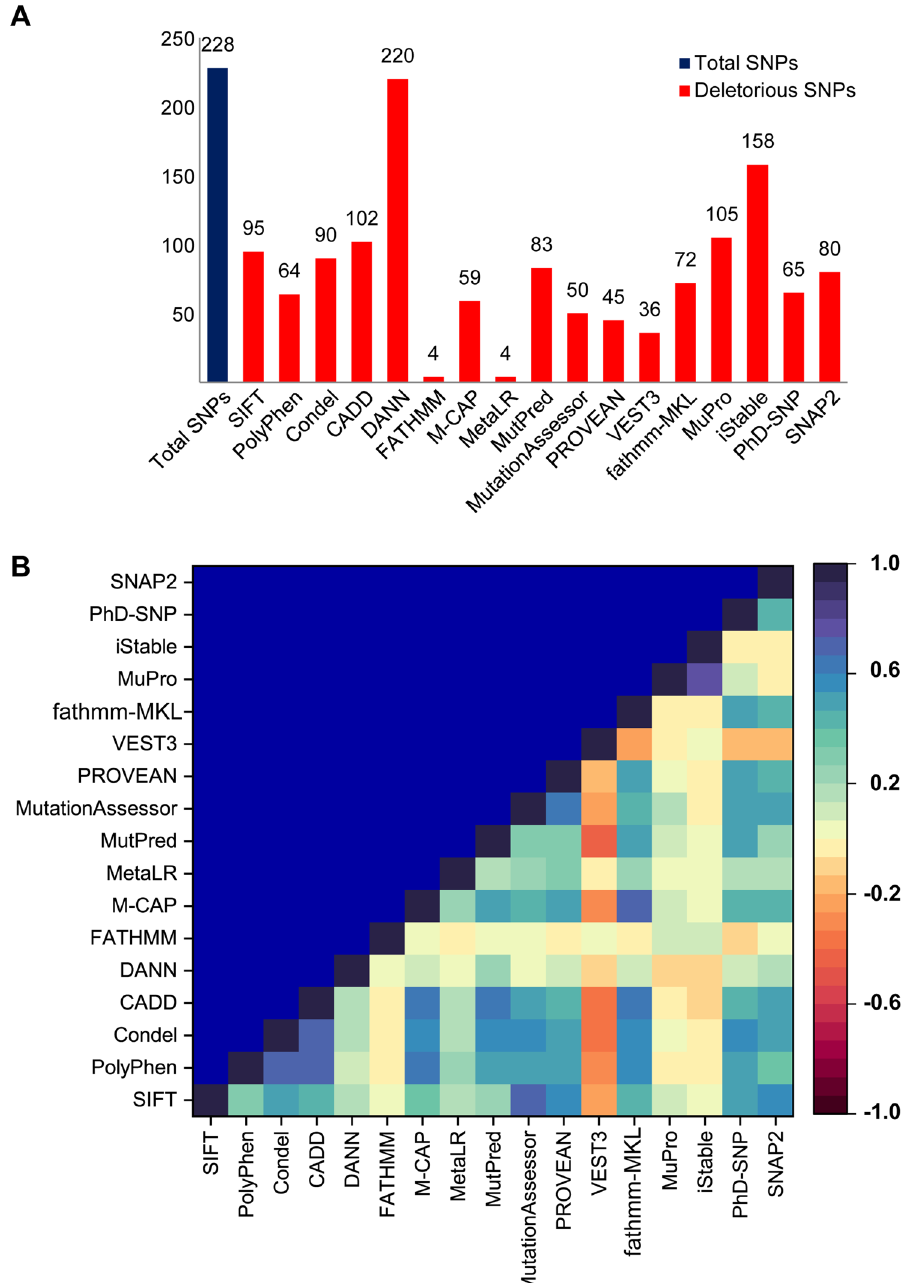
Figure 1. Identification of deleterious SNPs in TREM2 using different computational algorithms. ( A ) Numbers of total and deleterious SNPs predicted by each tool. ( B ) Pairwise correlations between deleterious SNP predicting algorithms presented as a color-coded heatmap, which shows a positive correlation ( +) when algorithmic predictions agreed and a negative correlation (−) when they